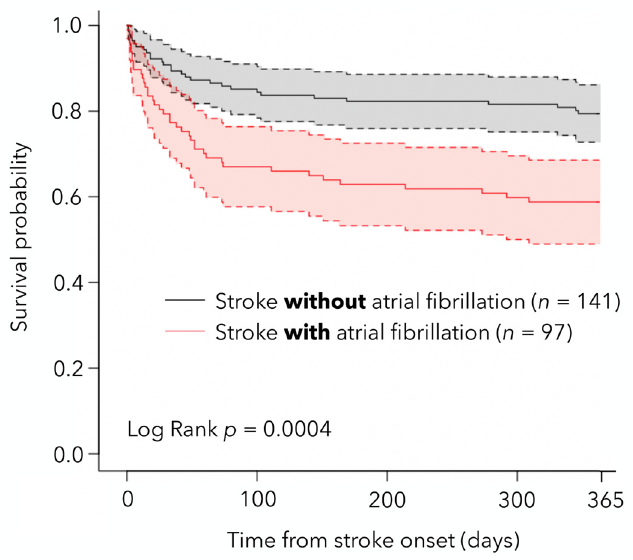
Figure 2. Kaplan–Meier survival plots and 95% confidence intervals for ischemic stroke patients with and without atrial fibrillation. Table 3. Case fatality, functional outcome, and health-related quality of life of stroke patients with and without atrial fibrillation at 90 days.